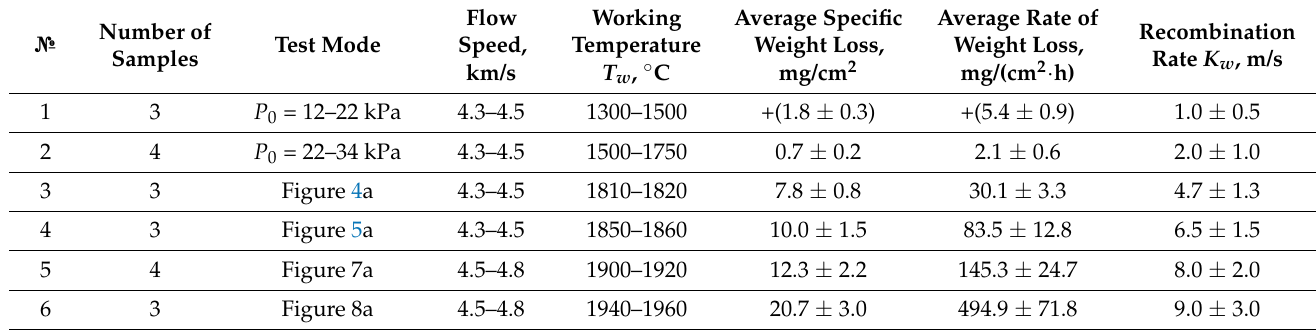
Table 3. Results of gas-dynamic tests of C f /C–SiC samples with a coating of the Si–TiSi 2 –MoSi 2 –TiB 2 –CaSi 2 system at dif- ferent modes.